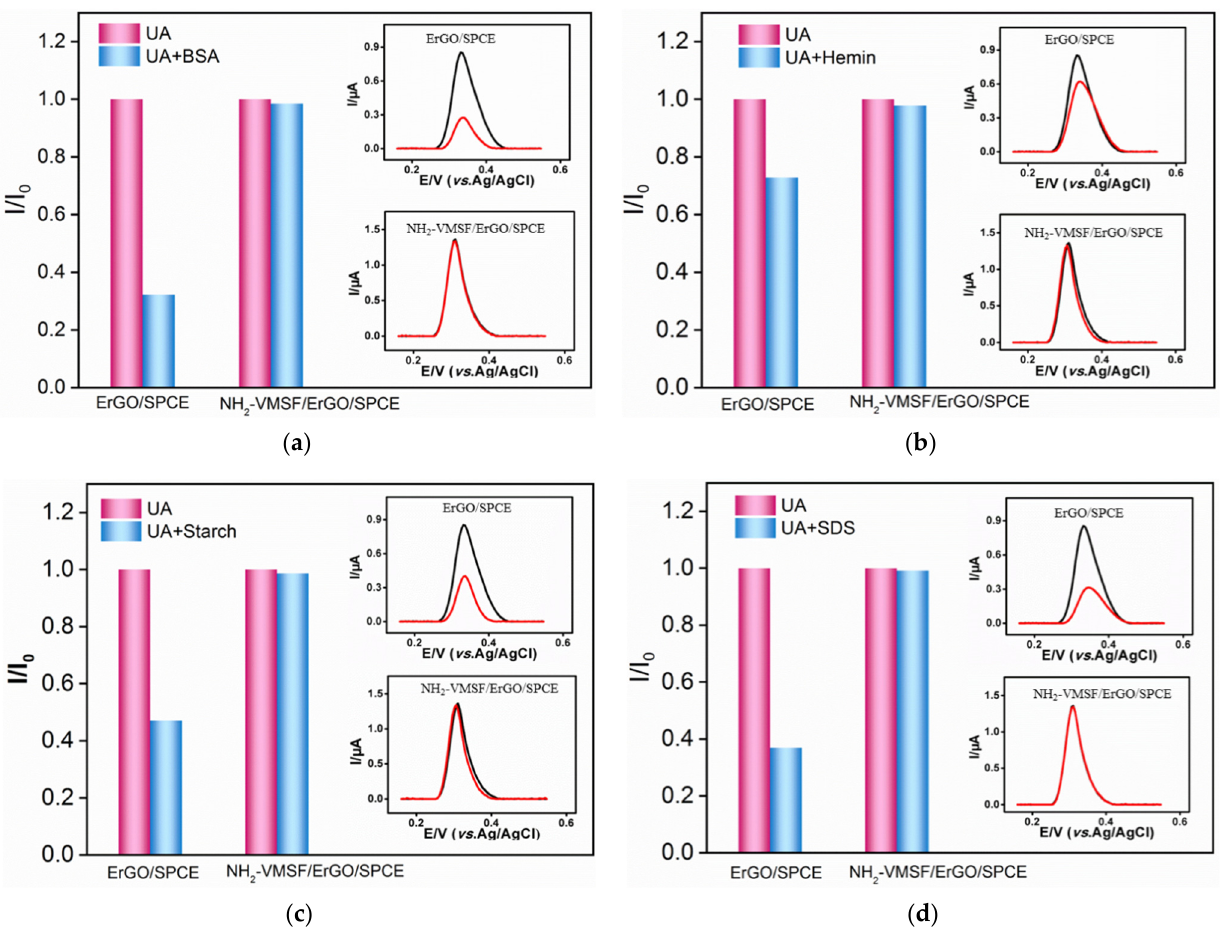
Figure 5. The peak current ratio of UA (10 μ M) on ErGO/SPCE or NH 2 -VMSF/ErGO/SPCE in absence ( I 0 ) or presence ( I ) of 50 μ g/mL BSA ( a ), hemin ( b ), starch ( c ) or SDS ( d ). Insets are the corresponding differential pulse voltametric curves obtained in single UA (black) or binary mixture (red).